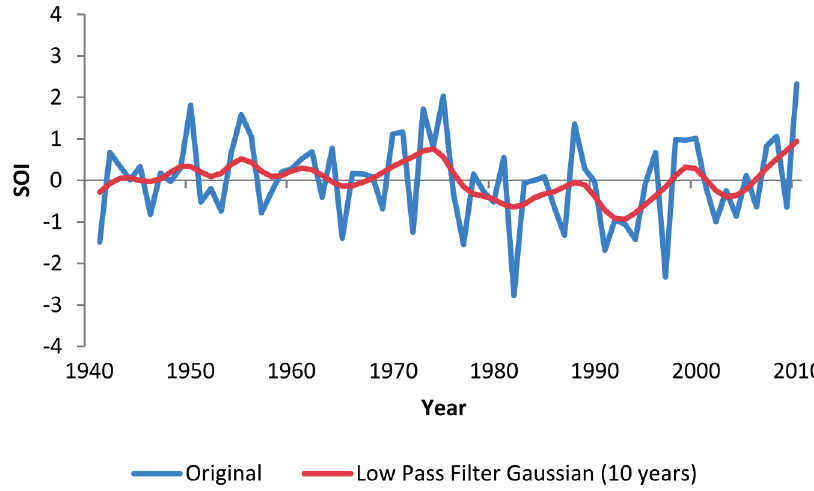
Figure 4. Southern Oscillation Index (SOI).